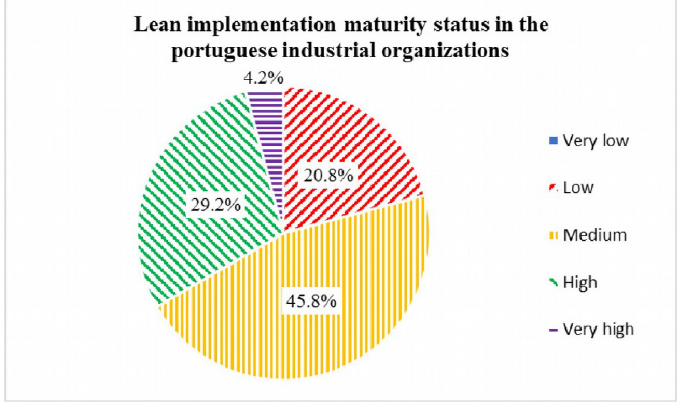
Figure 2. Lean implementation maturity